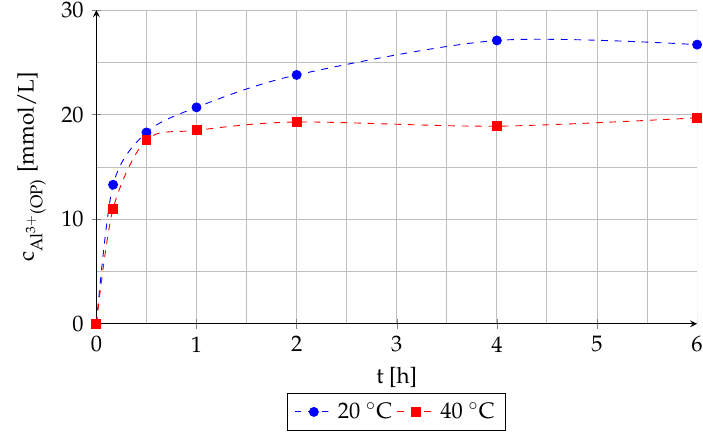
Figure 5. Kinetics of Al 3 + extraction (experiment (3) ).